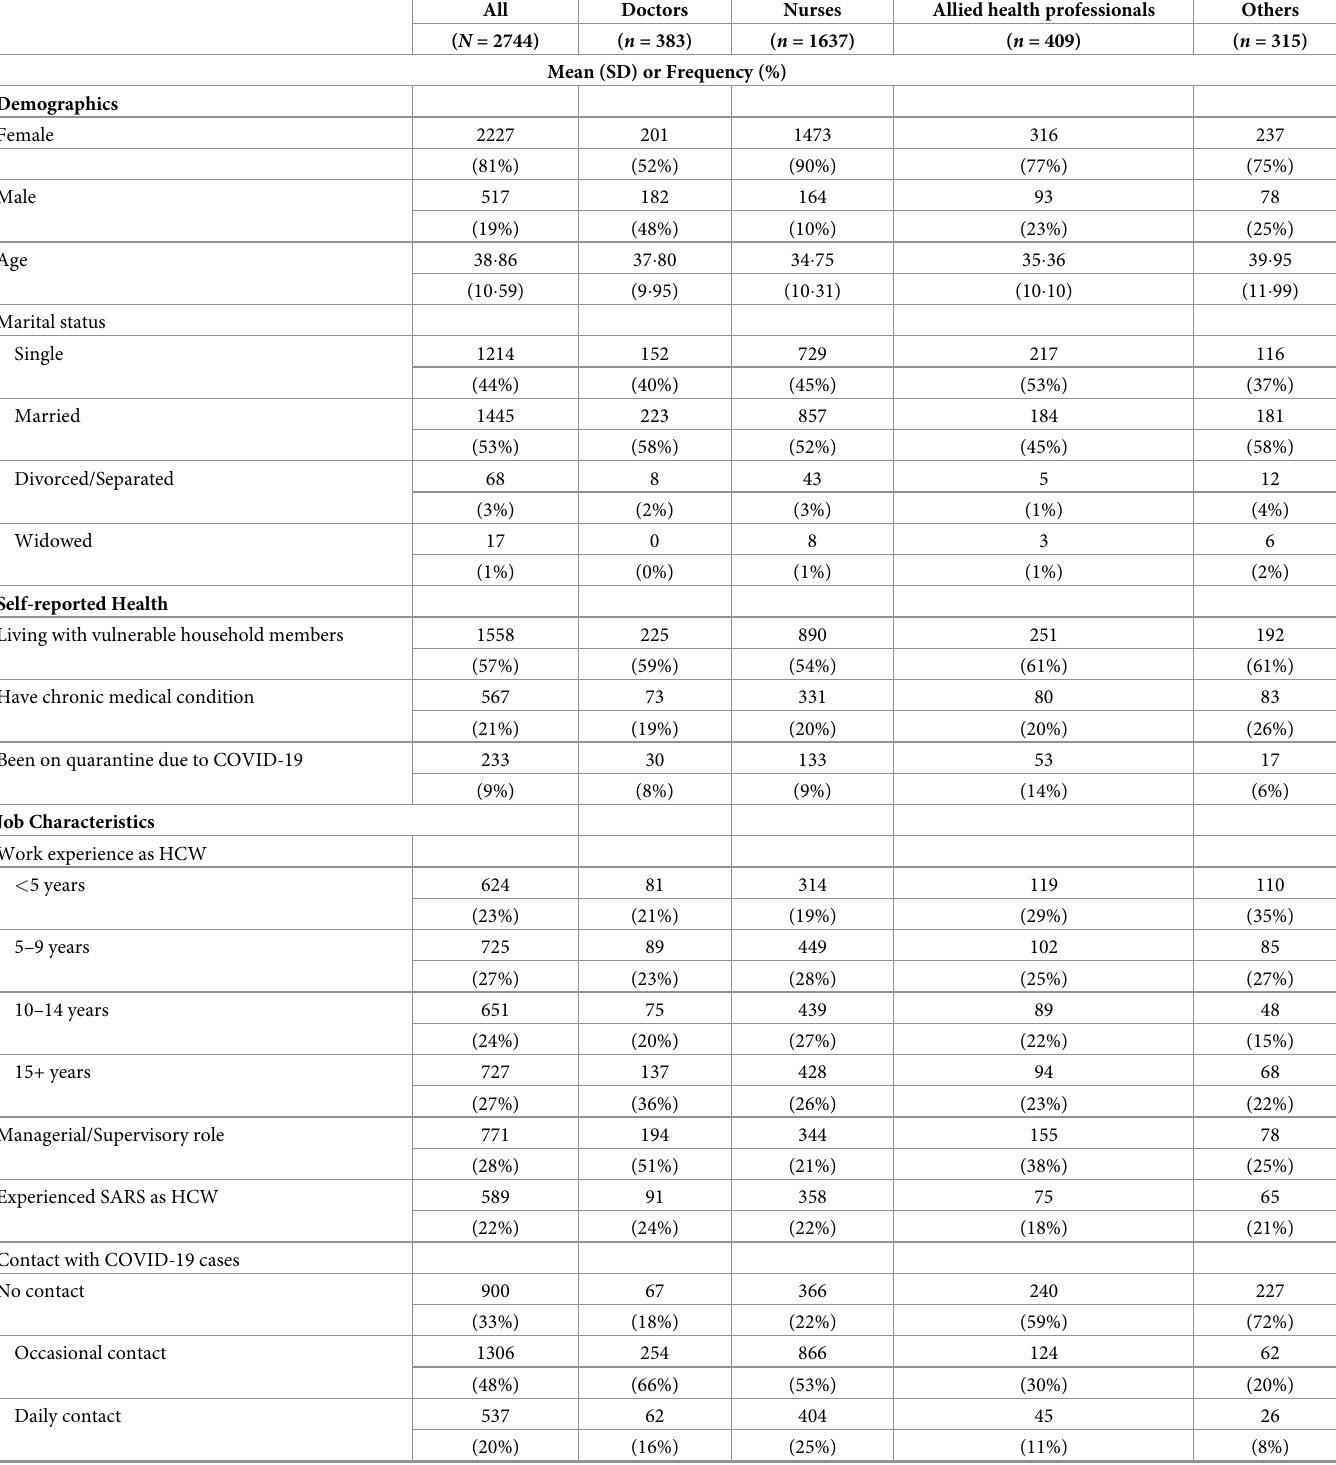
Table 1. Healthcare worker characteristics ( N = 2744).